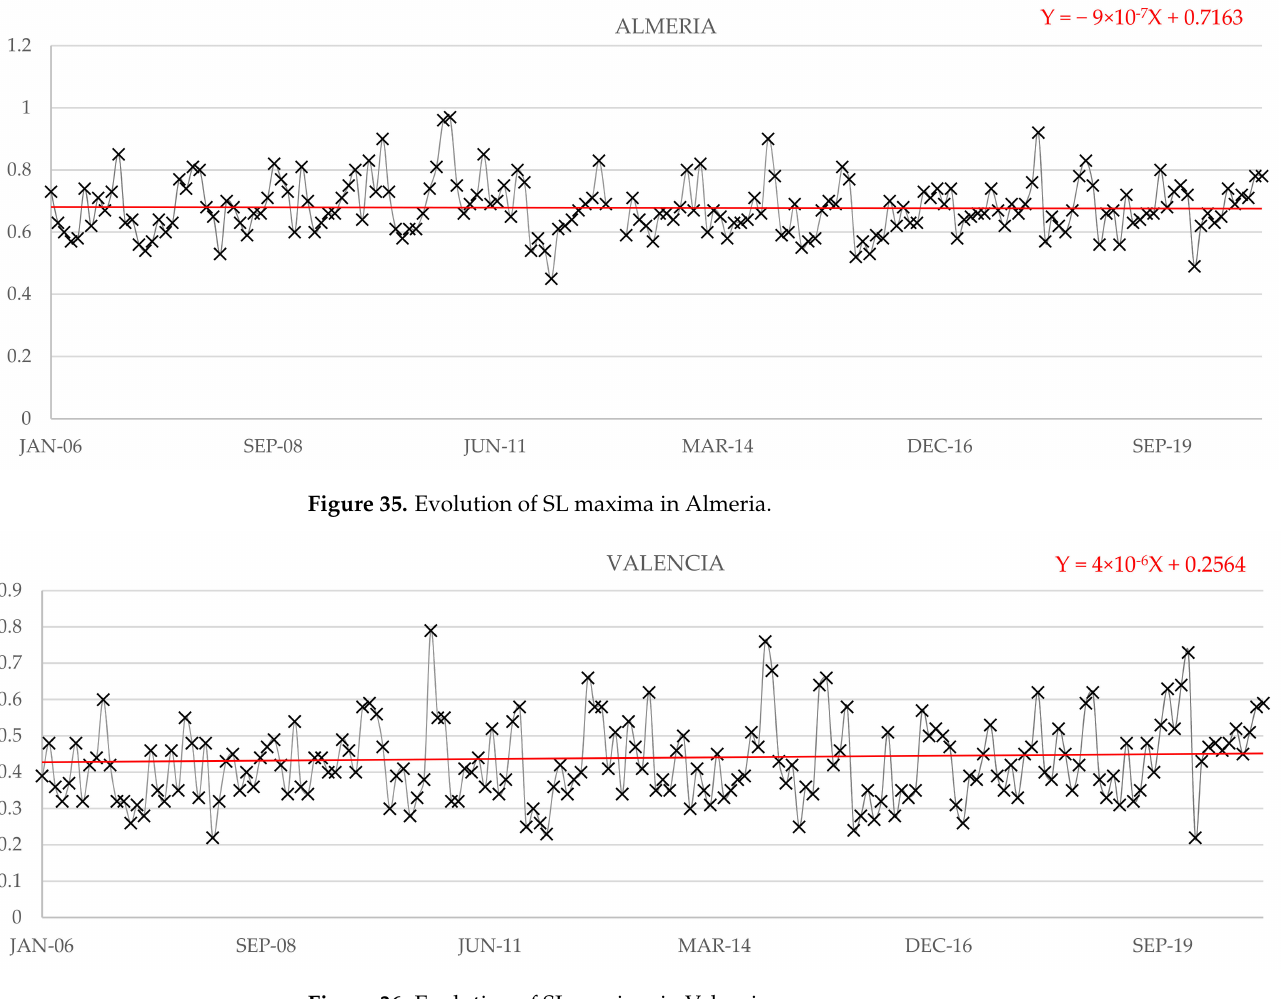
Figure 36. Evolution of SL maxima in Valencia.